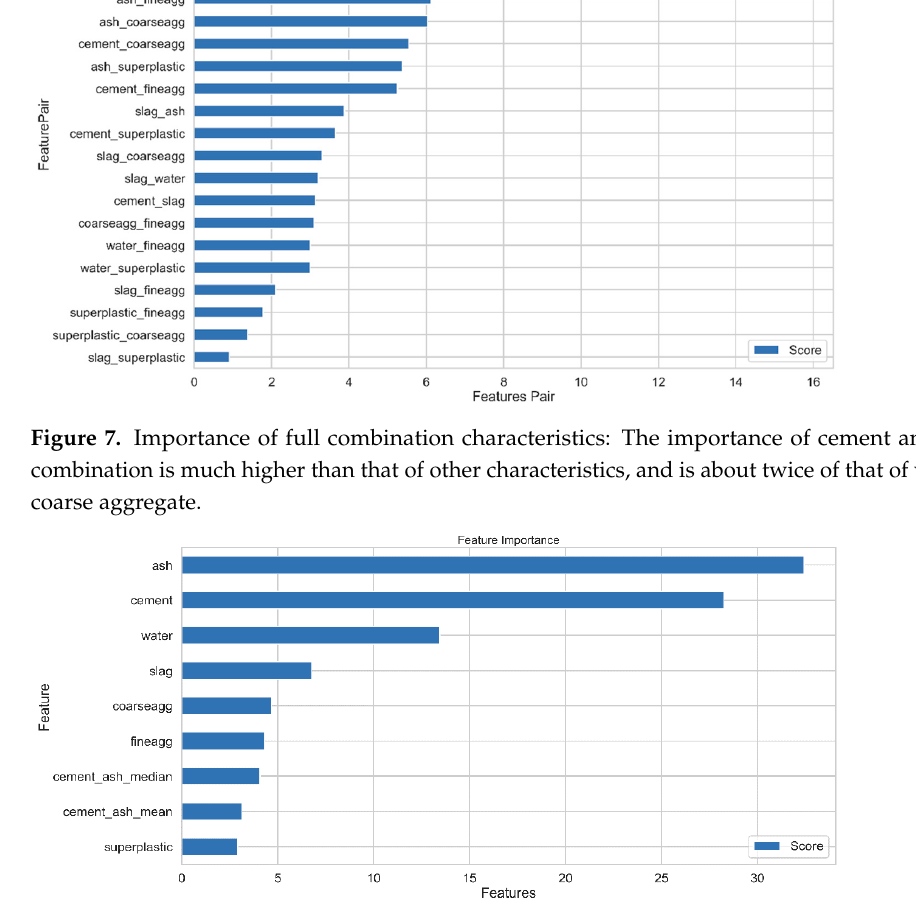
Figure 8. Feature importance of new feature set: The median of the combined characteristics of cement and fly ash was more important than its mean. Table 7. ELI5 feature weight. The median importance of cement and fly ash combination char- acteristics was 0.0217 ± 0.0093, higher than the mean of 0.0153 ± 0.0109. Cement_ash_median indicates the median value of combination features, and cement_ash_mean indicates the mean value of combination